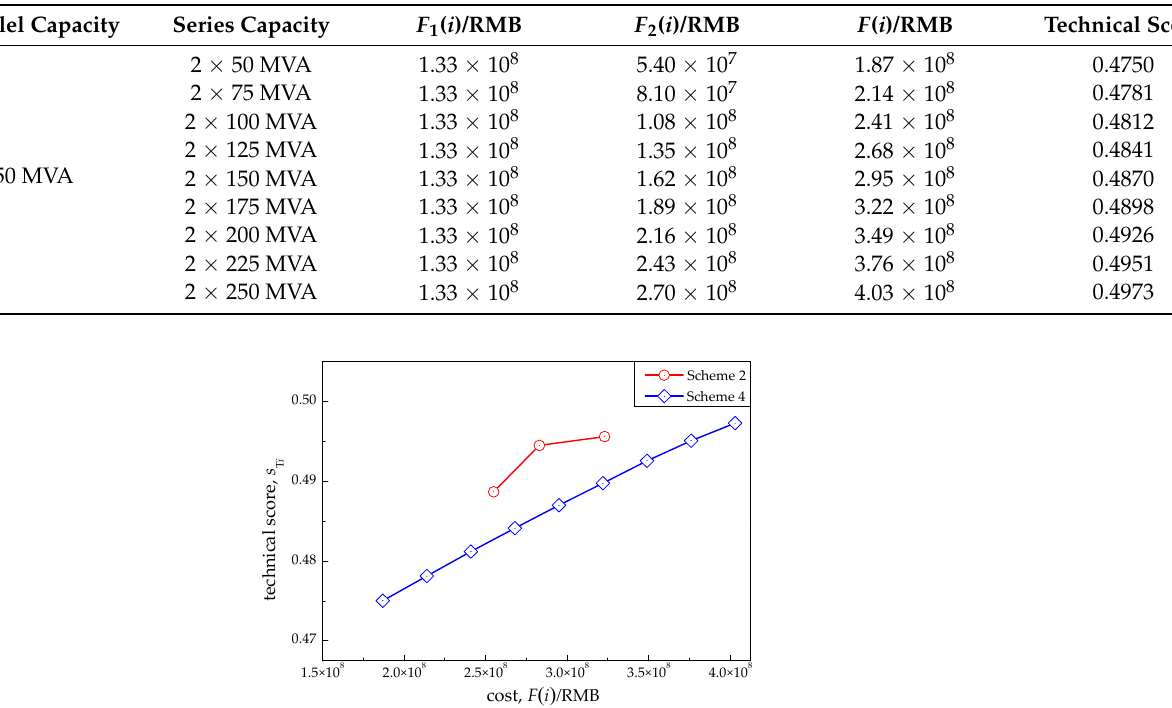
Table 11. The estimated costs and the technical scores of Scheme 4.